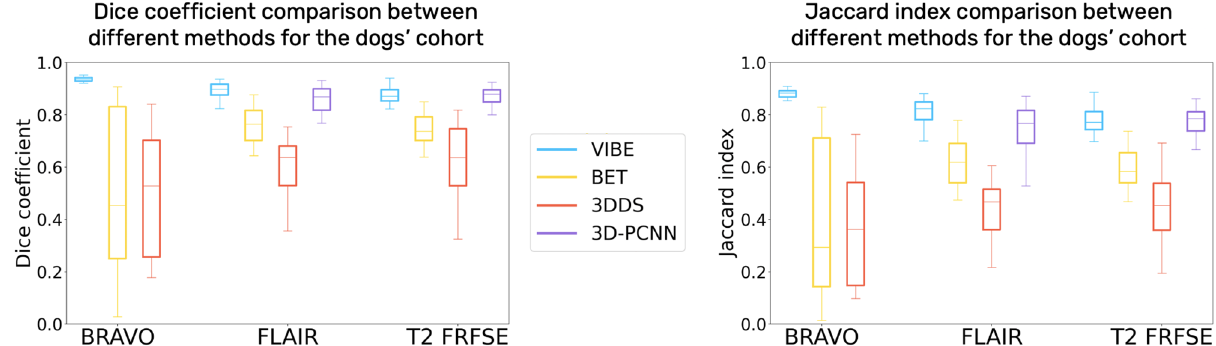
Figure 2. Dice similarity coefficient and Jaccard index Boxplot for the dogs cohort, comparing VIBE, BET, 3DSS and 3D-PCNN for three different sequences: T1 BRAVO, T2 FLAIR and T2 FRFSE.